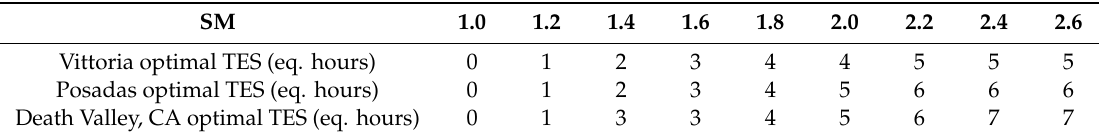
Table 6. Optimal TES and SM assessment for the three areas under study.